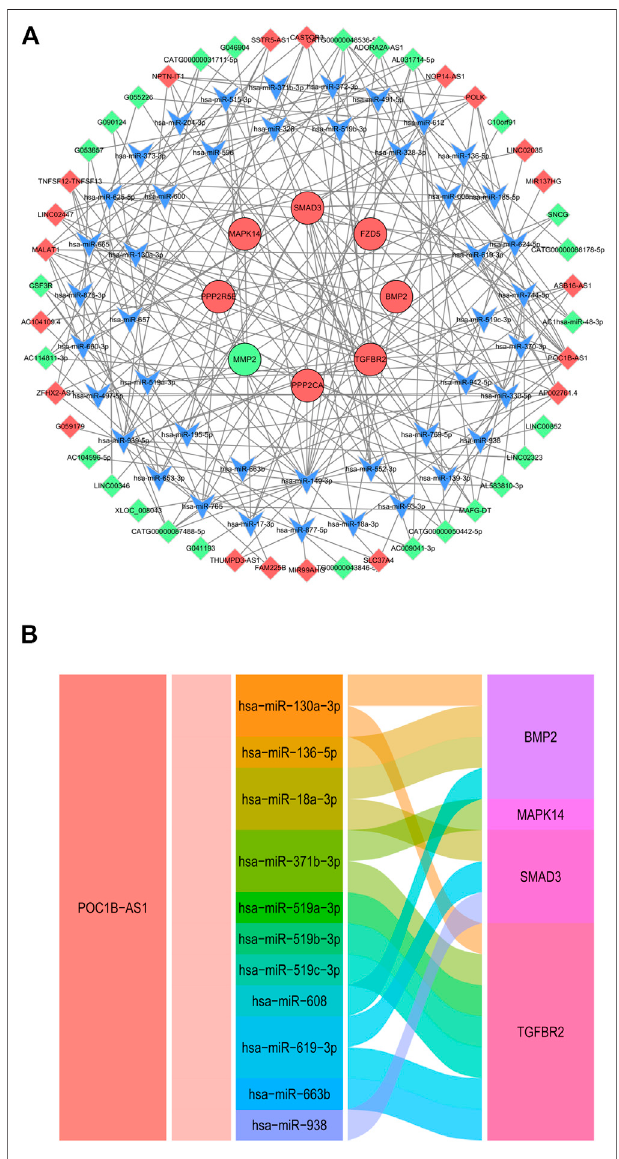
FIGURE 8 | CeRNA Analysis. (A) CeRNA network of 19 DE mRNAs and all DE lncRNAs. Red and green ellipses were upregulated and downregulated DE mRNAs, respectively. Red and green diamonds were upregulated and downregulatedDElncRNAs,respectively.BlueVwasmiRNA. (B) Alluvial diagram of lncRNA POC1B-AS1-miRNA-mRNA. CeRNA, competing endogenous RNA; DE, differentially expressed.